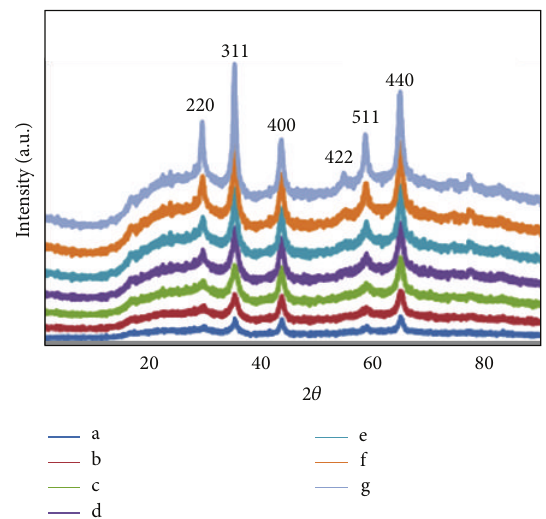
Figure 1: Powder X-ray diffraction patterns of Co 0(a), 0.1(b), 0.2(c), 0.4(d), 0.6(e), 0.8(f), and 1(g) } calcinated for 1h at 800 ∘